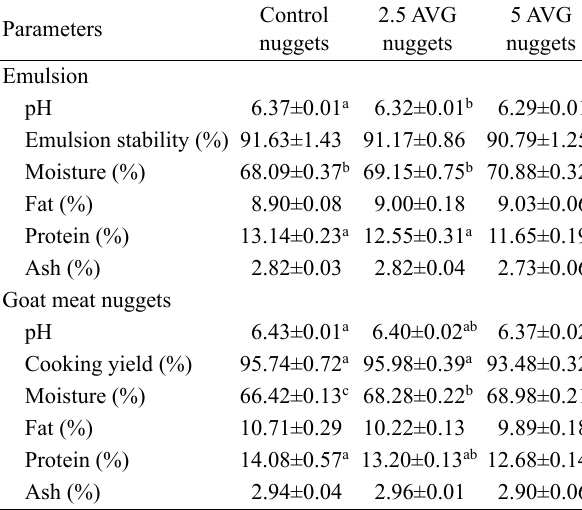
Table 1. Effect of Aloe vera gel on pH, emulsion stability, proximate composition of emulsion and goat meat nuggets